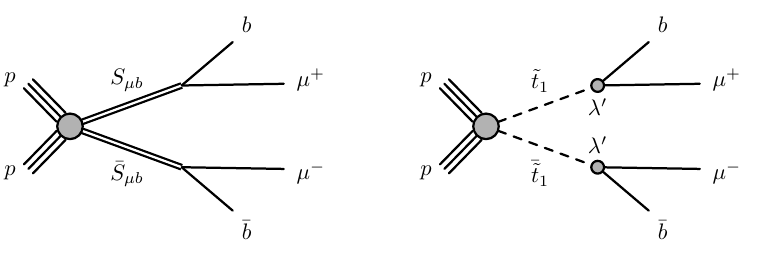
(cid:22) S ! ( b(cid:22) + )((cid:22) b(cid:22) left ) and pp ! ~ t (cid:0) ) ( (cid:22)b (cid:22)b